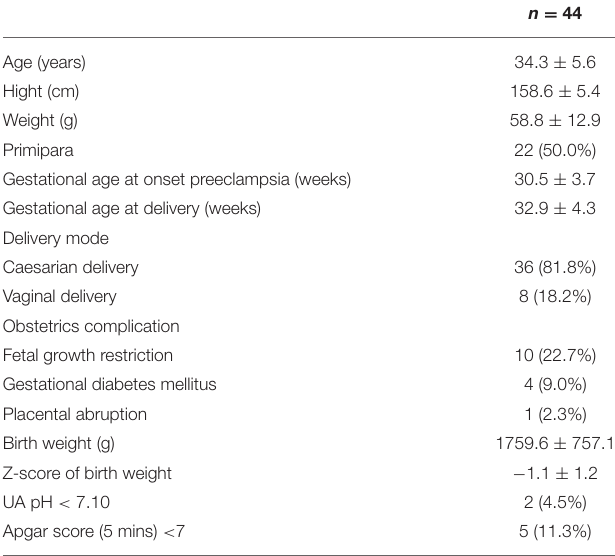
TABLE 1 | Maternal and neonatal